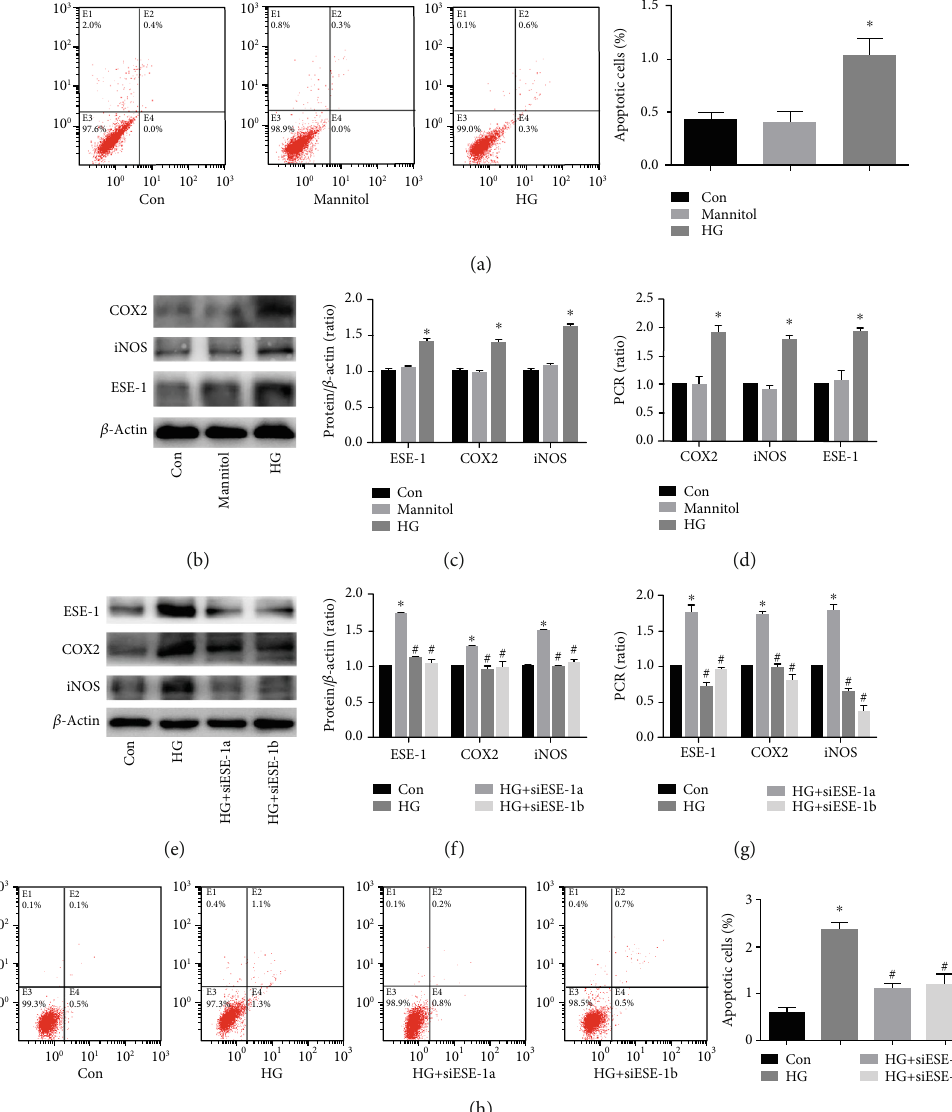
Figure 1: High glucose induced cyclooxygenase 2 (COX2) and inducible nitric oxide synthase (iNOS) expression via upregulation of E26 transformation-speci fi c sequence transcription factor-1 (ESE-1) in human umbilical vein endothelial cells (HUVECs). (a) Flow cytometry was used to detect apoptotic HUVECs cultured in normal glucose, osmotic control, or high glucose medium. Compared with the control group, high glucose treatment increased apoptosis in HUVECs. Osmotic control had no e ff ect on cell apoptosis. (b, c) Western blot analysis of ESE-1, iNOS, and COX2 in HUVECs cultured in normal glucose, osmotic control, or high glucose conditions. Compared with the control group, high glucose treatment increased ESE-1, iNOS, and COX2 protein expression in HUVECs. The osmotic control had no e ff ect on cell apoptosis. (d) The mRNA expression of ESE-1, iNOS, and COX2 was examined by qPCR in HUVECs grown in normal glucose medium, osmotic control medium, or high glucose medium. Compared with the control group, high glucose treatment increased ESE-1, iNOS, and COX2 mRNA expression in HUVECs. The osmotic control had no e ff ect on cell apoptosis. (e, f) The e ff ects of siESE-1 on high glucose-induced COX2 and iNOS expression were measured by Western blot analysis in HUVECs. siESE-1 decreased ESE-1, iNOS, and COX2 protein expression in hyperglycaemic HUVECs. (g) The e ff ects of siESE-1 on high glucose-induced COX2 and iNOS expression were measured by qPCR in HUVECs. siESE-1 decreased ESE-1, iNOS, and COX2 mRNA expression in hyperglycaemic HUVECs. (h) The e ff ects of siESE-1 on high glucose-induced apoptosis in HUVECs. siESE-1 decreased cell apoptosis in hyperglycaemic HUVECs. siESE-1: small interfering RNA ESE-1. ∗ P < 0 : 05 , compared with the control group; # P < 0 : 05 , compared with high glucose